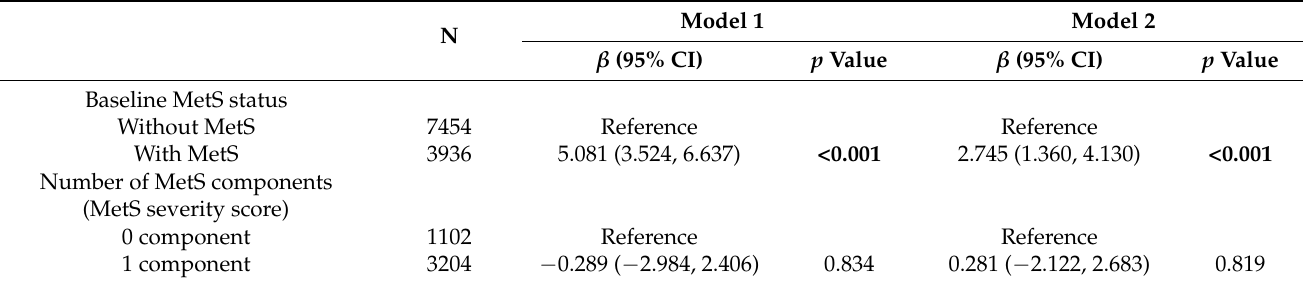
Table 3. Longitudinal associations of baseline metabolic syndrome status and its components with follow-up daytime napping